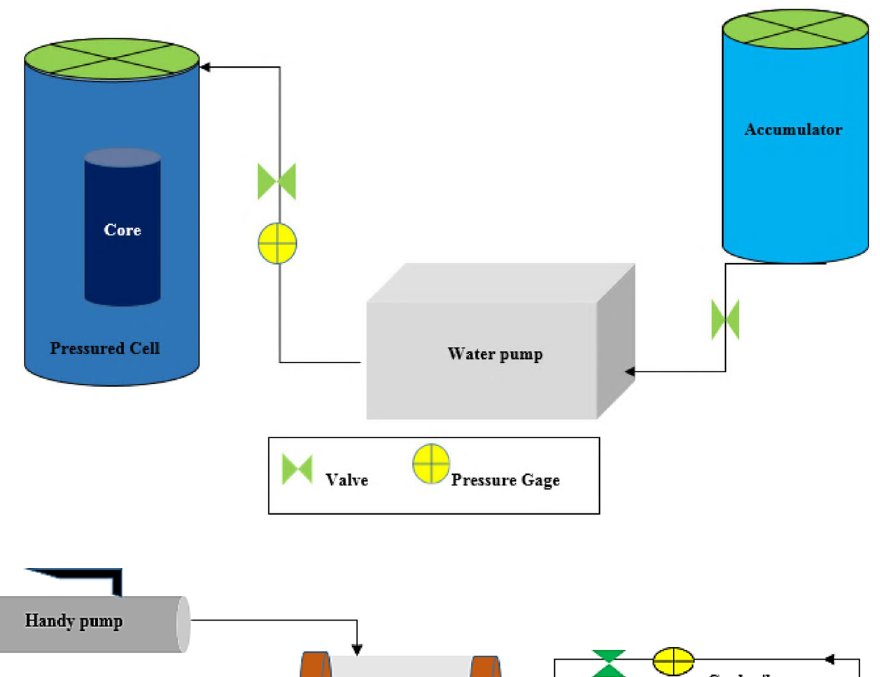
Fig. 3 A schematic form of cell under pressure for core saturation